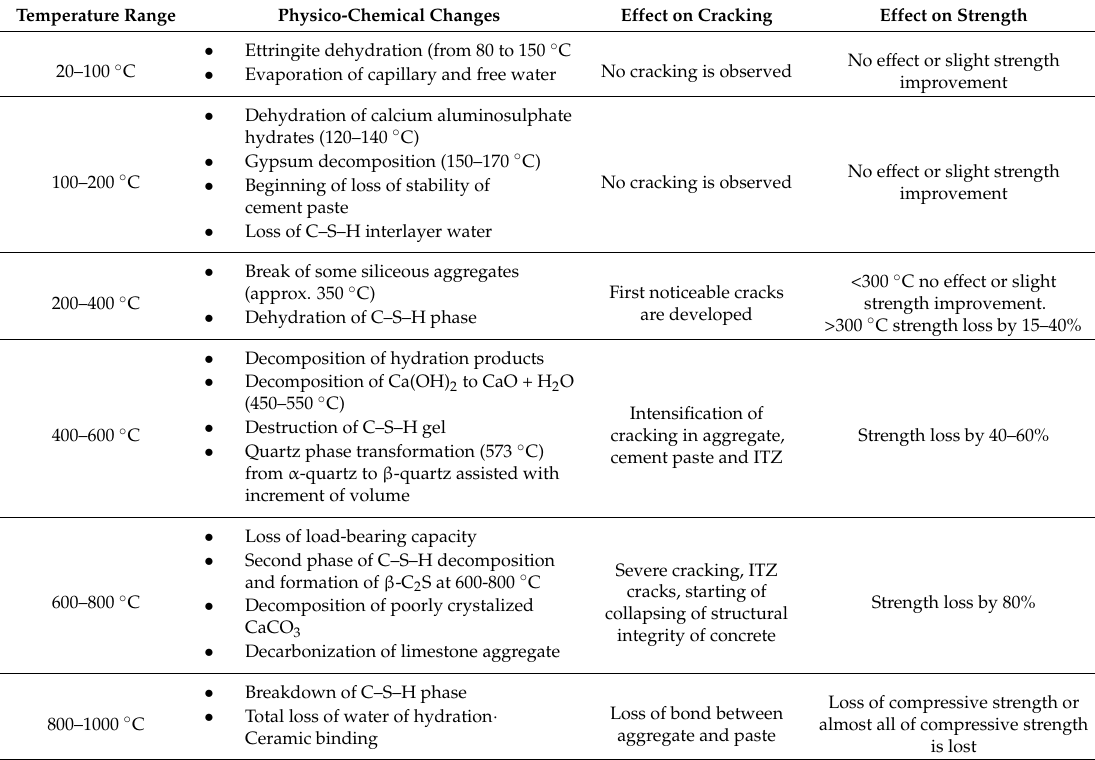
Figure 2. The effect of temperature on the change of phase composition of cement paste with w/c = 0.67. Reproduced with permission from [17]. Copyright Elsevier, 2009. Table 1. The effects of temperature on physico-chemical, visual, and mechanical properties of cement-based composites exposed to elevated temperatures. Based on: [1–3,5,9,10,13]. Temperature